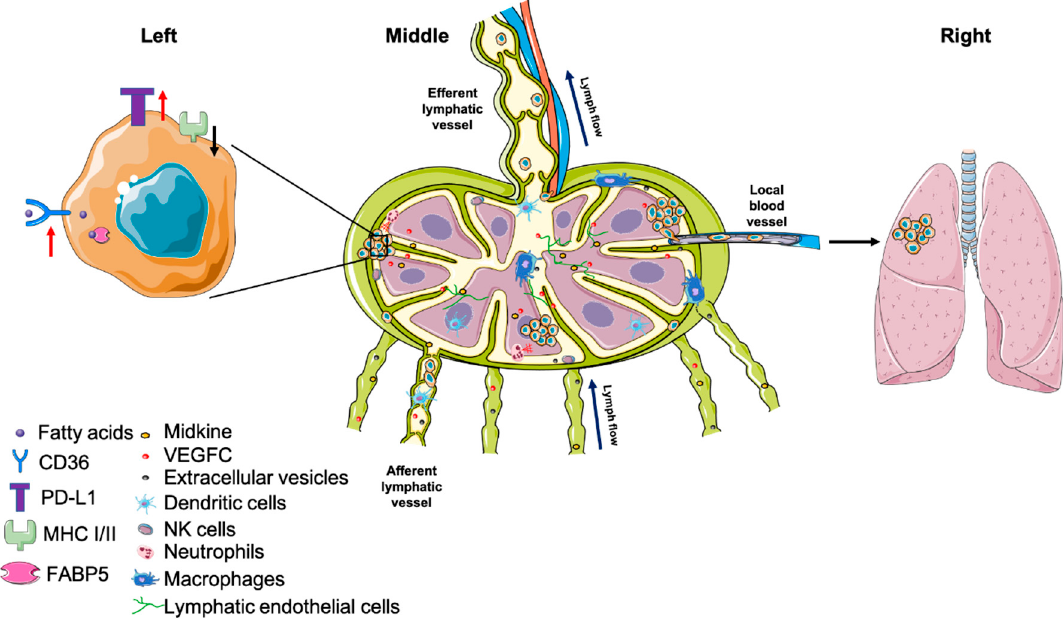
Figure 2. Cancer cells survive in lymph nodes and spread to other organs. ( Left ) To adapt to the lipid-rich environment in lymph nodes, cancer cells enhance their reliance on fatty acid metabolism by upregulating CD36 and FABP5. In addition, to avoid immune destruction, cancer cells increase expression of the immunosuppressive checkpoint molecule PD-L1, while decreasing MHC I/II expression. ( Middle ) Midkine and VEGF-C secreted by cancer cells induce lymphangiogenesis in draining lymph nodes prior to seeding, generating a pre-metastatic niche. Similarly, cancer cells also release extracellular vesicles to interact with B cells in the cortex, promoting lymph node metastasis. Although the lymph node is filled with various immune cell populations, the microenvironment is immunosuppressive. Tolerogenic DCs, M2-like TAMs, and CD15+ TANs were enriched in metastatic lymph nodes. These cells contribute to inhibition of cytotoxic T cells. The lytic activity of NK cells is also reduced in metastatic lymph nodes. ( Right ) After surviving in the lymph node, cancer cells can invade the lymph node blood vasculature and further spread to distant organs. Cancer cells can also exit through the efferent lymphatic vessel.